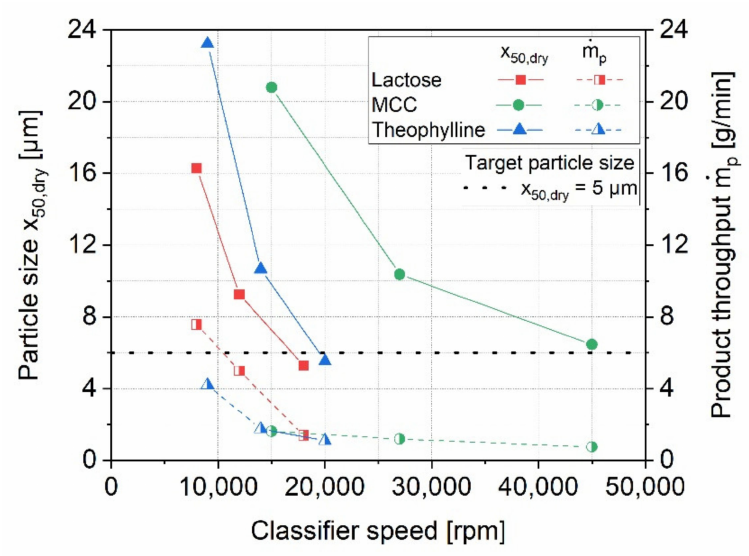
. m p , as functions of the classifier speed using